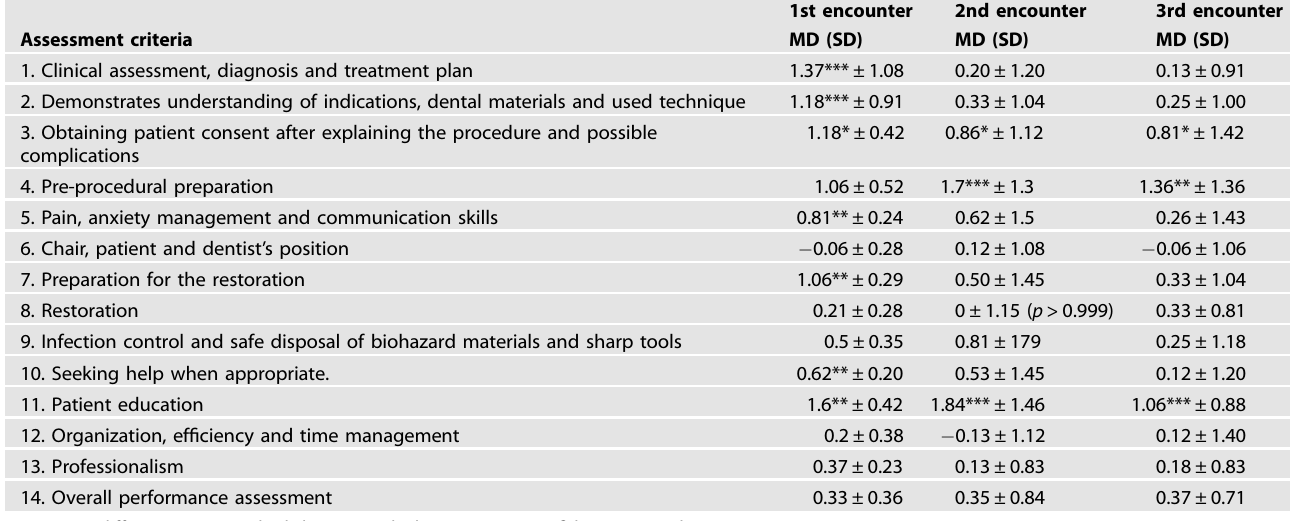
Table 3. Paired t -test showing the mean difference between peers and faculty in each assessment criteria in each